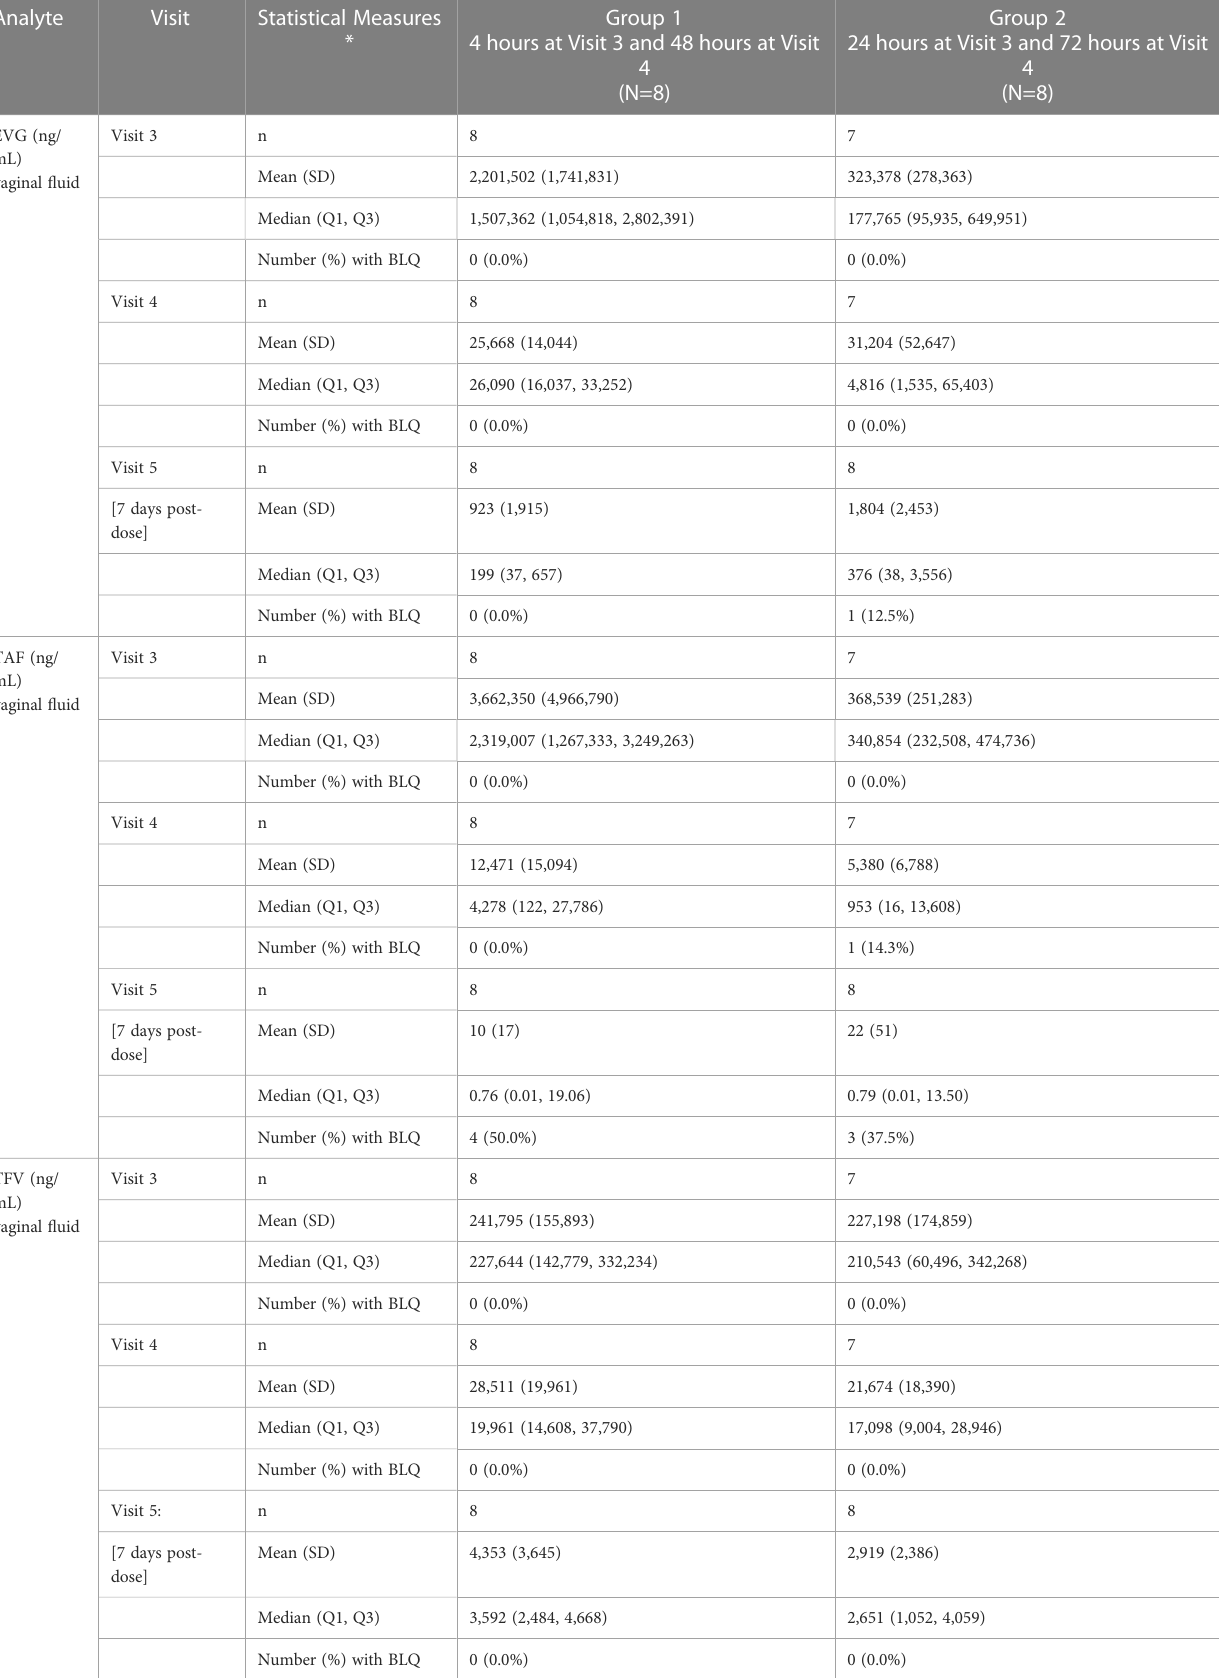
TABLE 3 Concentrations of EVG, TAF and TFV (ng/mL) in vaginal fl uid.